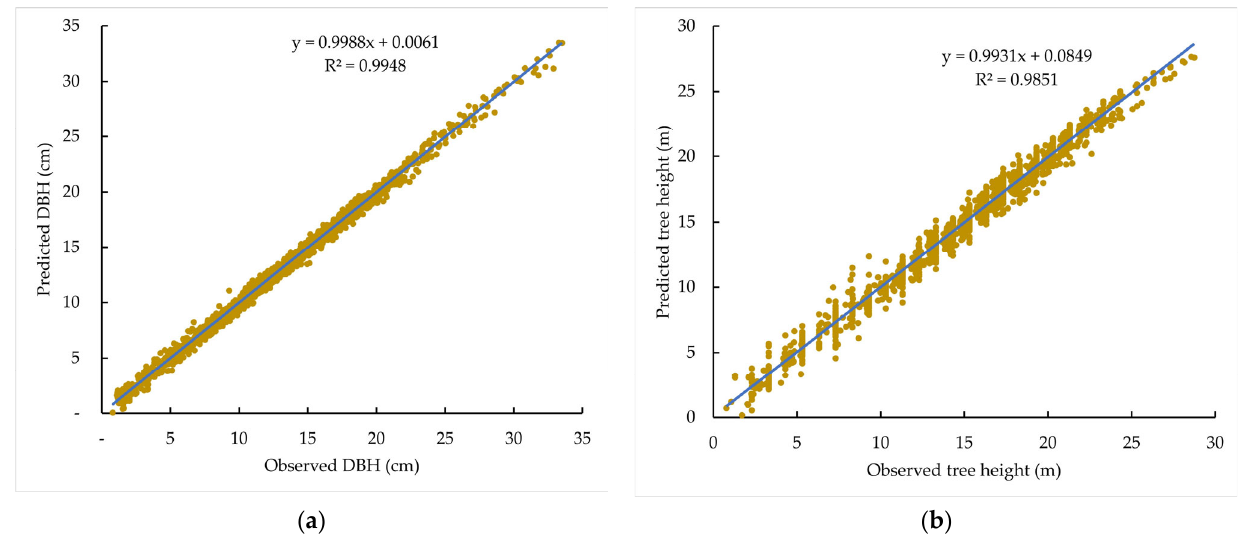
Figure 4. Predicted tree size using Mitscherlich growth function; relationship between predicted DBH and observed DBH ( a ), between predicted tree height and observed tree height ( b ). R 2 is the correlation coefficient.